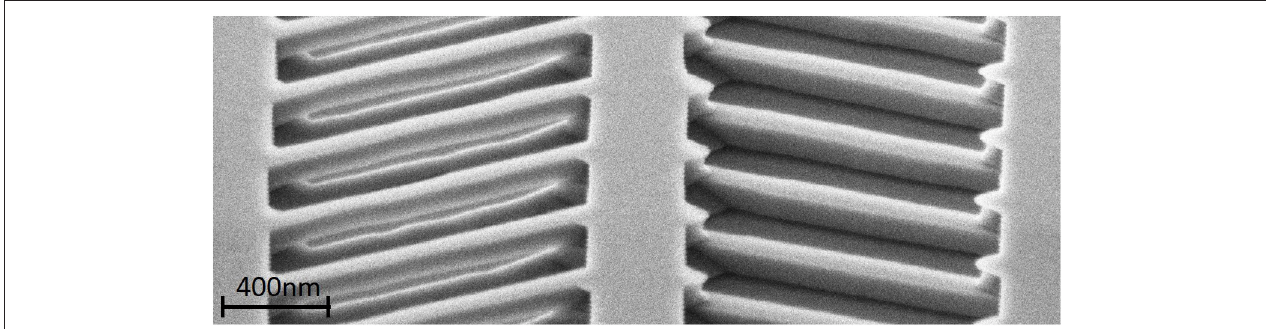
FIGURE 6 | SEM image taken at 54 ◦ tilt of aligned ( m = 0.0) fin-waveguide structure after ICP etching, TMAH anisotropic etching and oxide removal. The left fins (top SOI layer) are clearly suspended whilst the right fins (bottom SOI layer) have been over-etched.